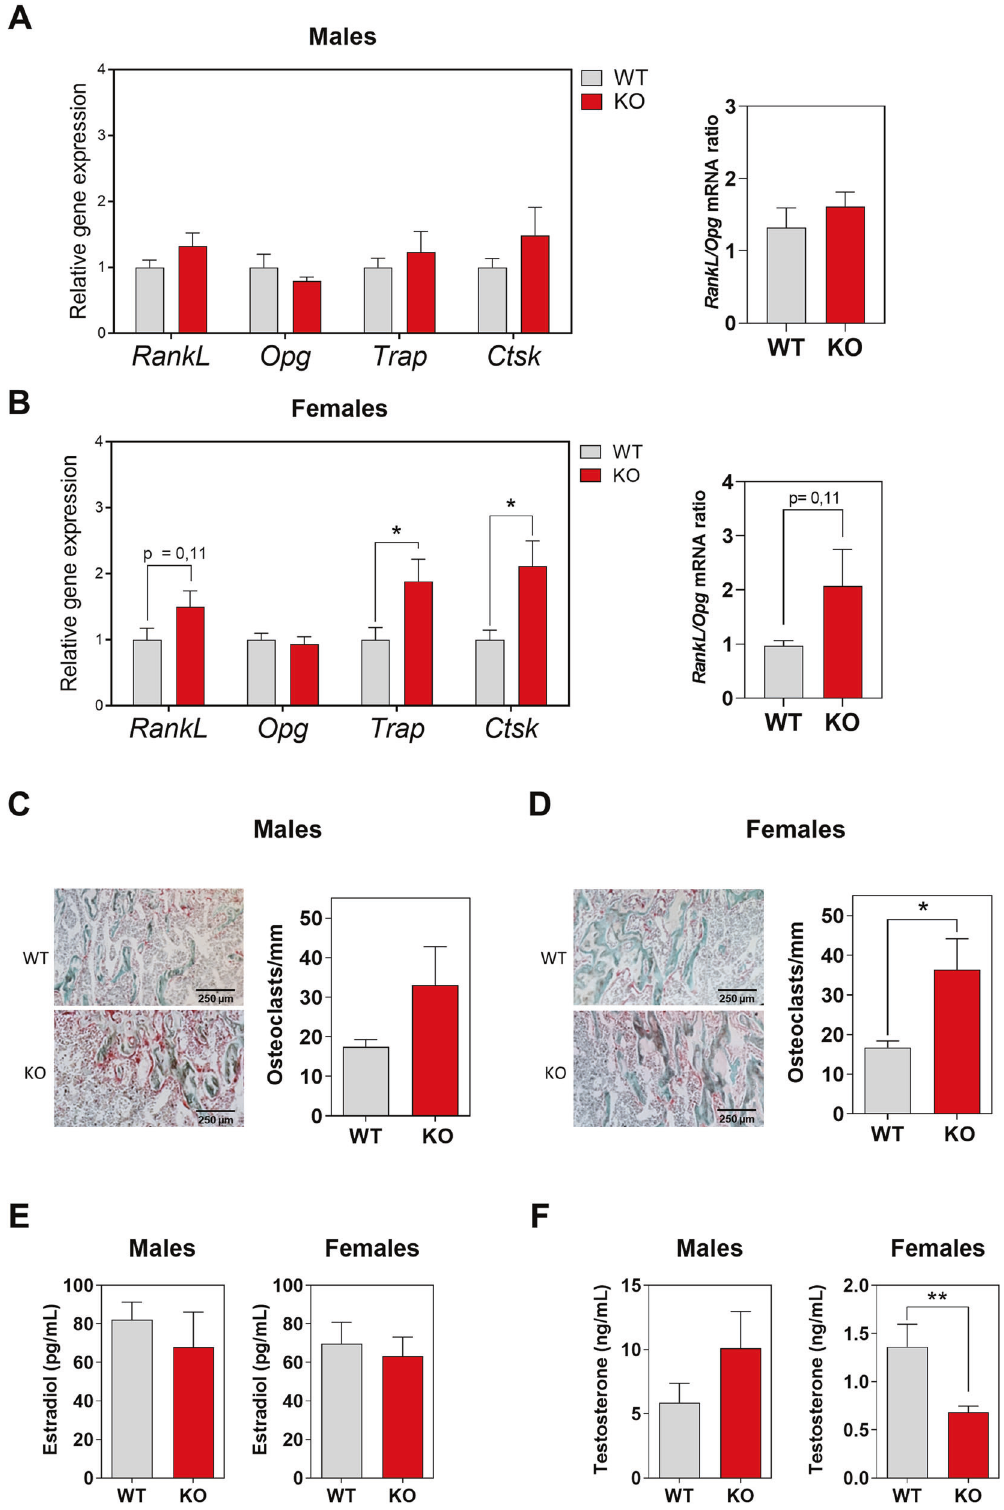
Fig. 5 HERC1 induces osteoclastogenesis. A , B We analyzed mRNA isolated from the femurs of 8-week-old WT or Herc1 KO mice by RT-qPCR, normalized to Gapdh , expression and show the Rankl/Opg mRNA ratio ( n = 5 – 9). C Histological analysis of femurs obtained from mice. C , D Representative images of longitudinal sections of femur from male and female KO mice stained with TRAP. Images were taken at ×4 magni fi cation. Osteoclasts number per surface of trabecular bone in both sexes in WT and Herc1 -KO mice ( n = 3 – 5). Estradiol ( E ) and testosterone ( F ) levels in the serum of WT and Herc1 -KO mice were measured by ELISA ( n = 10 – 15). Data are expressed as mean ± SEM. Signi fi cant differences are relative to WT mice. * p < 0.05; ** p < 0.01. KO knockout, WT wild-type.